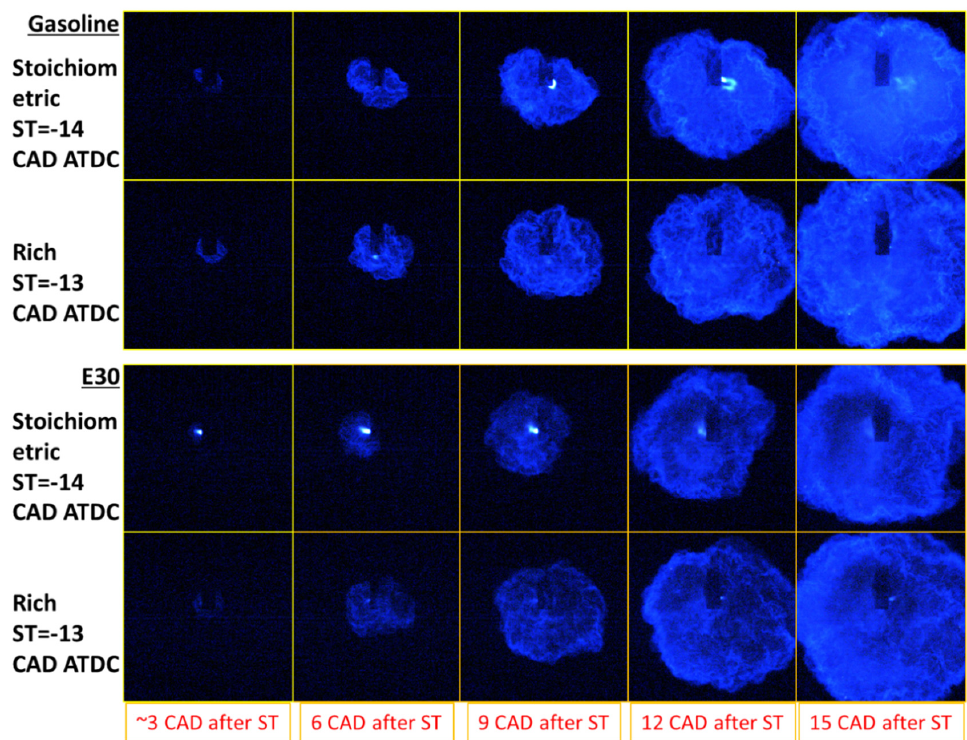
Figure 10. Flame propagation for stoichiometric and rich conditions, for gasoline and E30. The gain value for these images was set to 1.